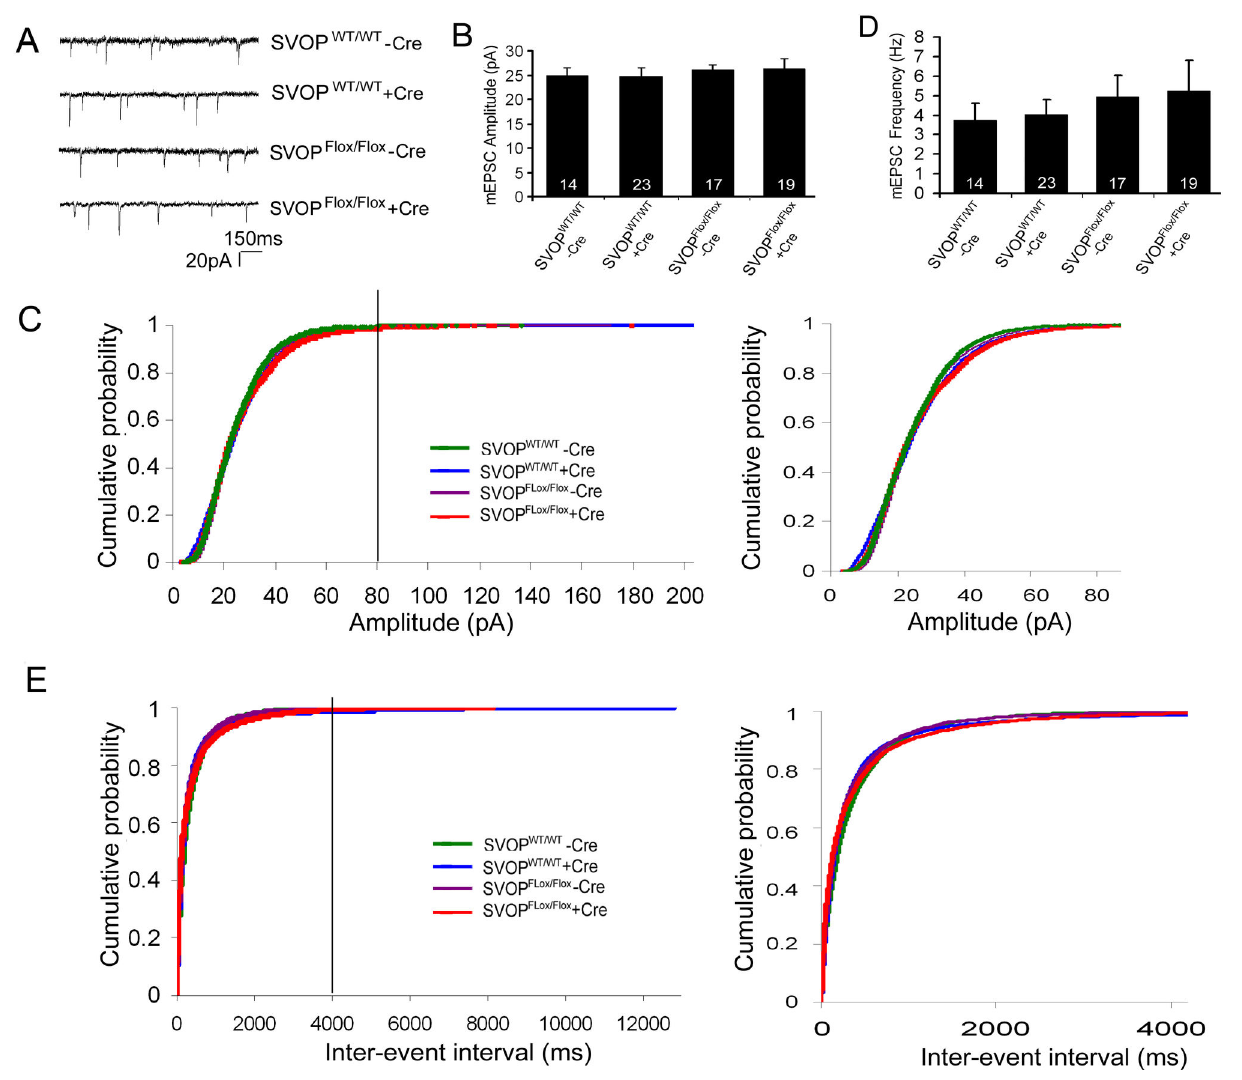
Figure 3. Loss of SVOP does not affect spontaneous neurotransmitter release. Shown are graphs summarizing peak amplitude and frequency of mEPSC. Autaptic hippocampal neurons cultured from mice homozygous for Floxed SVOP genes or wild type littermate controls were infected with lenti virions encoding Cre-eGFP or eGFP. Neurons were analyzed in the whole-cell voltage-clamp configuration at DIV 14-20. Cells were selected for recording according to green fluorescence expression with preference given to brighter cells. Neurons were held at −60 mV, and mini EPSC were recorded in 5 min epochs. Graphs show the mean ± SEM. The number of cells analyzed is indicated within each column. Data are from three different cultures. A) Representative traces of mini EPSCs recorded from autaptic hippocampal neurons. B) Mean amplitudes of mEPSCs were unchanged across four experimental groups (SVOP WT/WT - Cre, 24.78 ± 1.56 pA; SVOP WT/WT + Cre, 24.74 ± 1.73 pA, SVOP Flox/Flox - Cre 26.13 ± 1.10 pA and SVOP Flox/Flox + Cre 26.28 ± 2.03 pA, p = 0.88, two-way ANOVA). C) Cumulative probability plots of mEPSC amplitude. The left panel shows the full amplitude range, the right panel is a plot of events with amplitudes < 80 pA. D) No differences in mEPSC frequency were observed across all experimental groups (SVOP WT/WT - Cre, 3.76 ± 0.83 Hz; SVOP WT/WT + Cre, 4.00 ± 0.77 Hz, SVOP Flox/Flox -Cre 4.95 ± 1.06 Hz and SVOP Flox/Flox + Cre 5.24 ± 1.58 Hz, p = 0.76, two-way ANOVA). E) Cumulative probability plots of mEPSC inter-event interval of 4 experimental groups. The left panel is a plot of the full inter-event interval range, the right panel of inter-event intervals <4000ms.